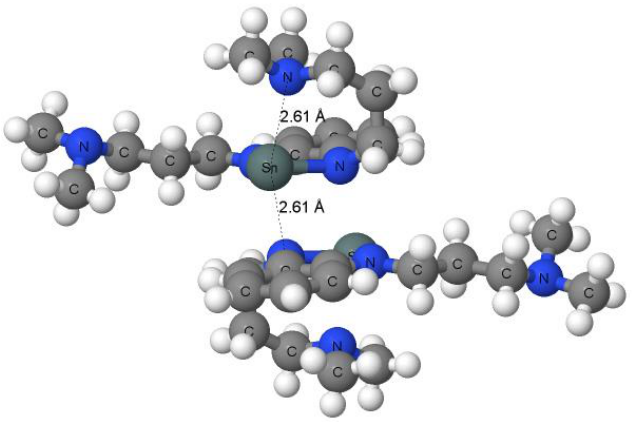
Figure 3. The fragment of the crystal structure of N,N (cid:48) -bis(3-(dimethylamino)propyl) benzimidazolin-2-stannylene. The closest contacts are indicated, an intermolecular contact and an intramolecular one.